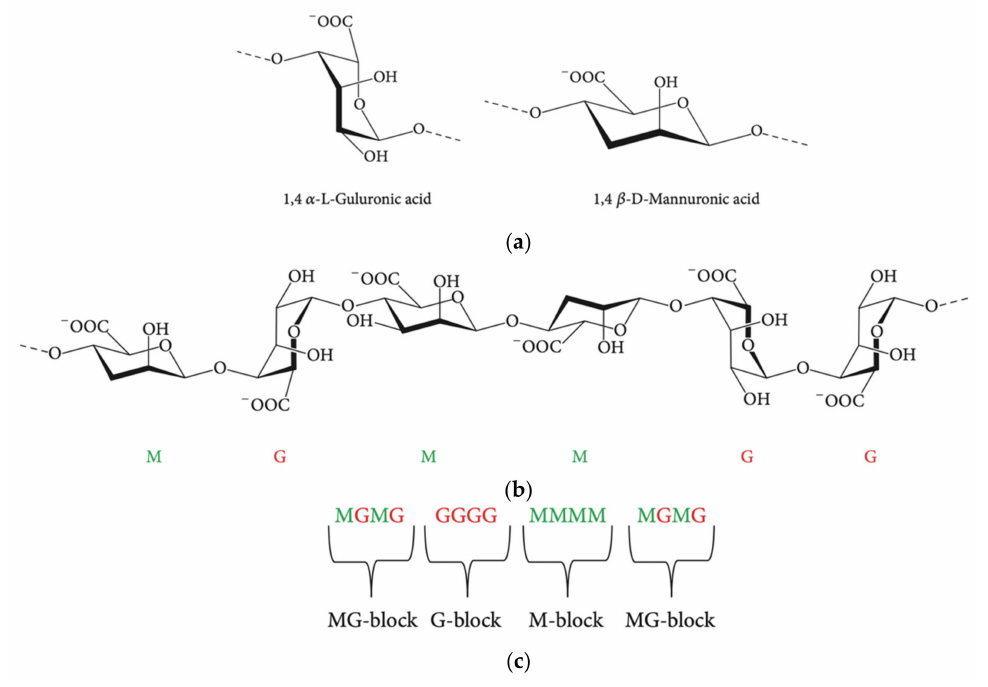
Figure 4. Structure of alginate ( a ) monomer, ( b ) chain conformation, and ( c ) distribution [120]. The biosynthetic pathway, as it is best understood in Pseudomonas aeruginosa , is en- coded by a single operon with 12 genes [116], starting with the synthesis of the active precursor guanosine-diphosphate (GDP)-mannuronic acid in cytosol. This is followed by polymerization by Alg8 polymerase-mediated transfer of sugar molecules from the donor to the growing acceptor molecule chain with the Alg8 polymerase (Figure 5). Finally, the periplasmic proteins help in modification and the product is exported [118].